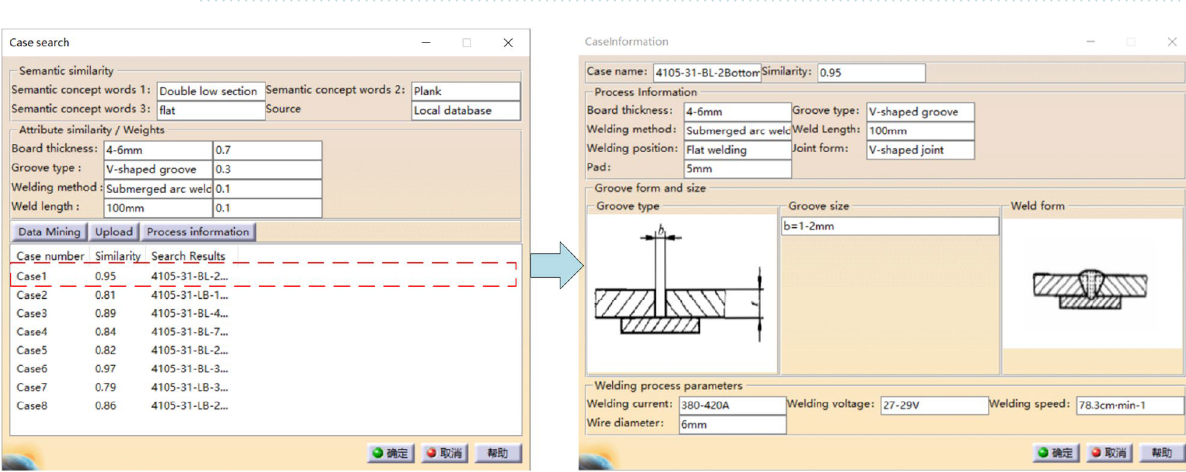
Figure 10. Constructing a heterogeneous model process knowledge graph.